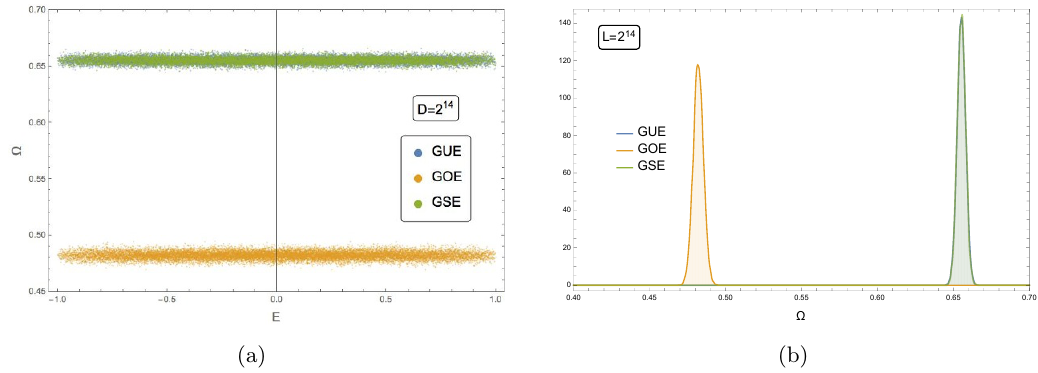
Figure 11 . Left: the distribution of the IR diversity of the GUE, GOE and GSE of dimension D = 2 14 versus the normalized energy E . The distributions of the GUE and GSE overlap. Right: the distribution of the IR diversity of the GUE, GOE and GSE of dimension D = 2 14 . The IR diversity of GUE, GOE and GSE follows the Gaussian distribution with mean (cid:25) 0 : 655 ; 0 : 482 and 0 : 655 and deviation (cid:25) 0 : 00278 ; 0 : 00336 and 0 : 00273, respectively.